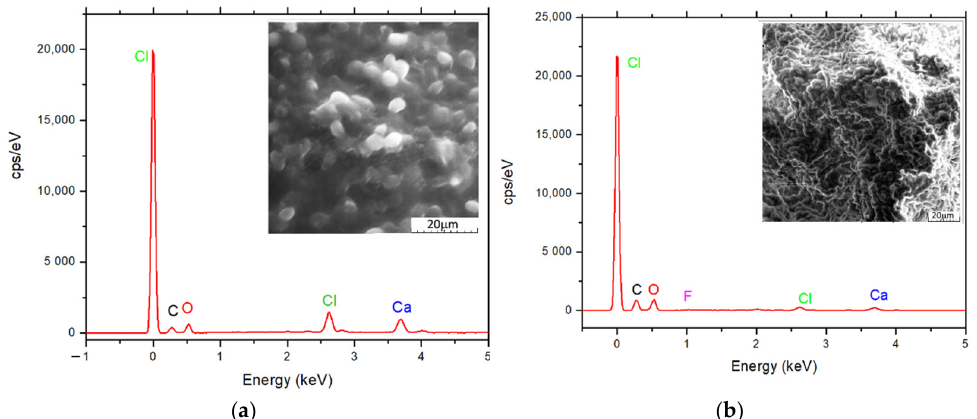
Figure 3. Scanning electron microscopy (SEM) and EDAX spectrum of the obtained polymeric mi- crobial biosorbent based on Saccharomyces pastorianus , immobilized using the two techniques: ( a ) a simple dropping technique; ( b ) encapsulated using a Buchi microencapsulator.